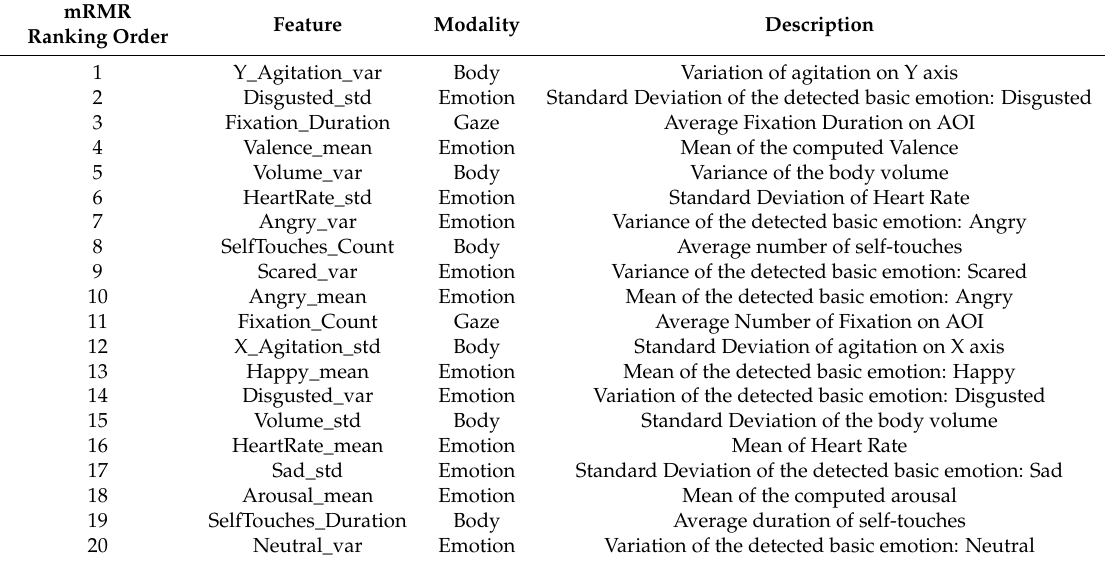
Table 5. Ordered list of the 20 most relevant features generated by mRMR algorithm [32]. mRMR Ranking Order